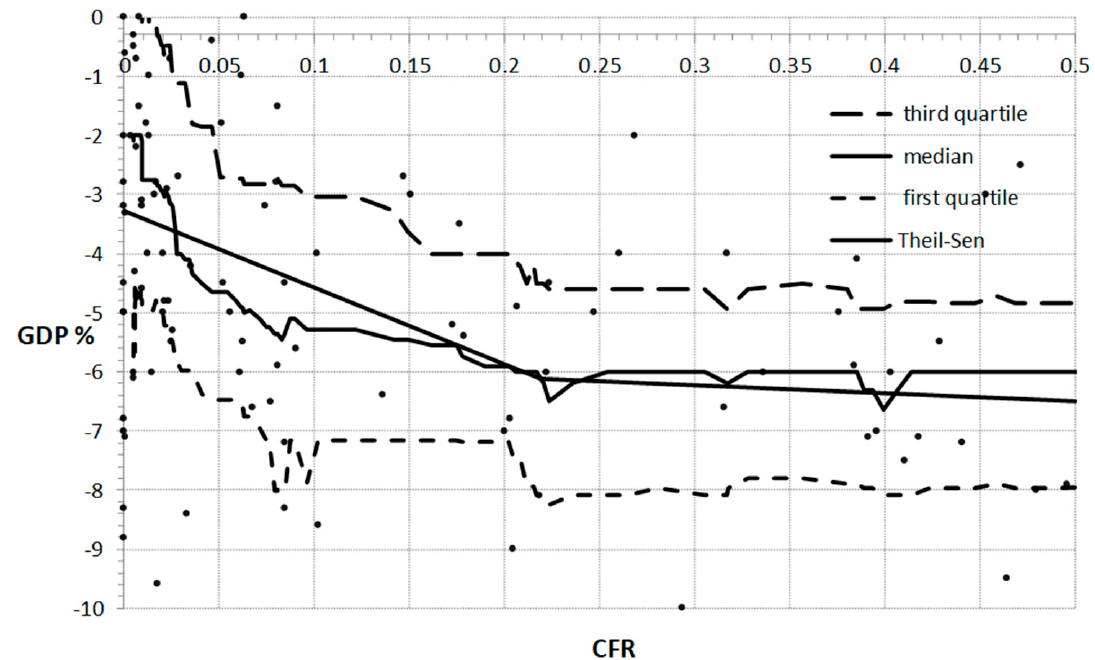
Figure 2. The relation between CCR and GDP with the moving median, first and third quartiles, and two-segment linear Theil–Sen approximation.